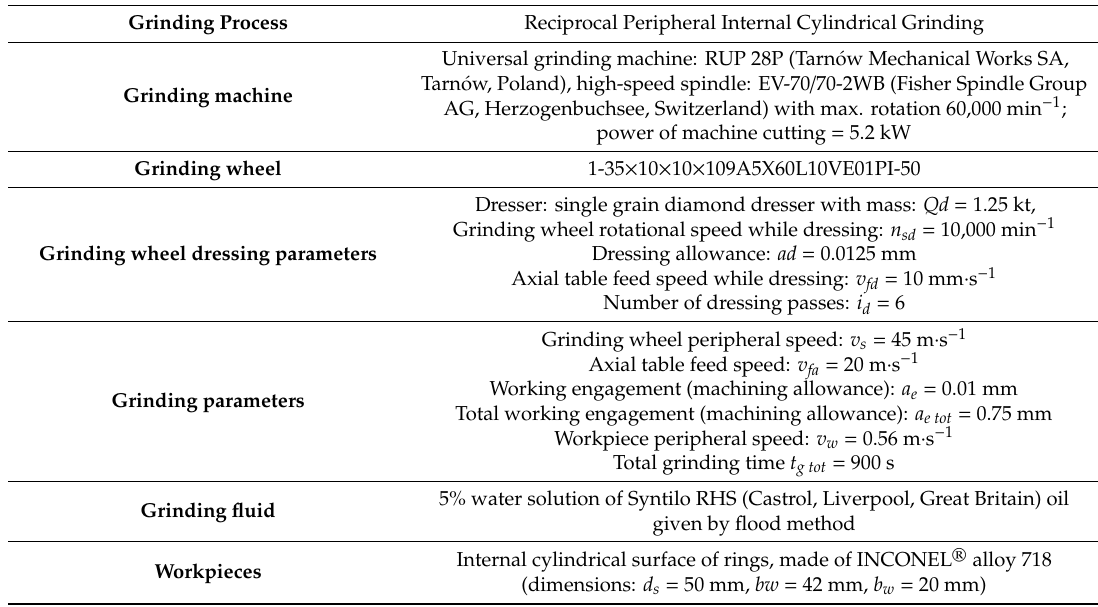
Table 6. Conditions of the grinding process.